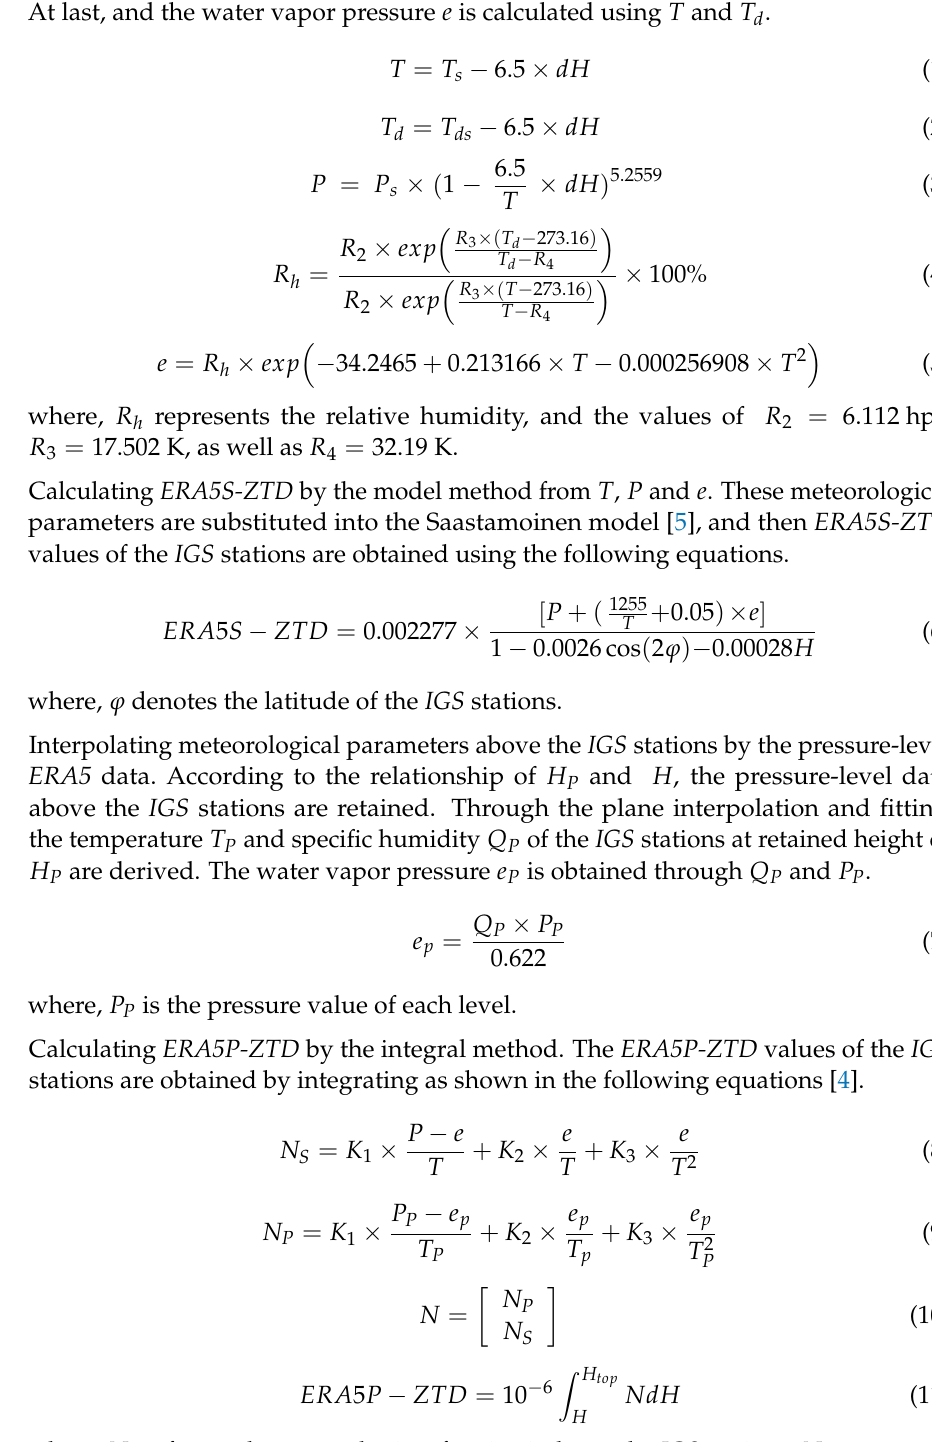
where, N S refers to the atmospheric refractive index at the IGS stations, N P represents N P in each IGS station. K 1 , K 2 and K 3 are the refractive index constants with